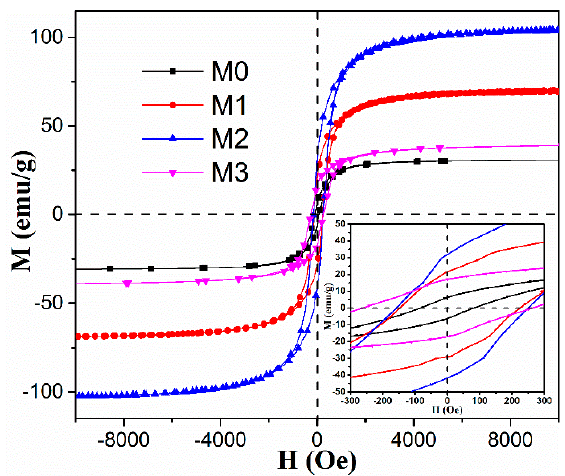
Figure 6. Hysteresis loops of the M0, M1, M2, and M3. The insert is the magnified loop.